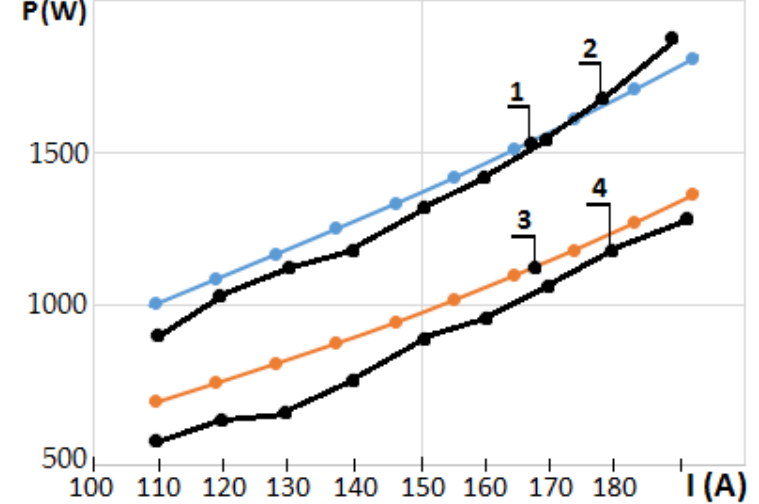
Figure 21. Comparison between analytically (1, 3) and experimentally (2, 4) estimated power losses, respectively at 12 kHz and 10 kHz, according to Figure 10.